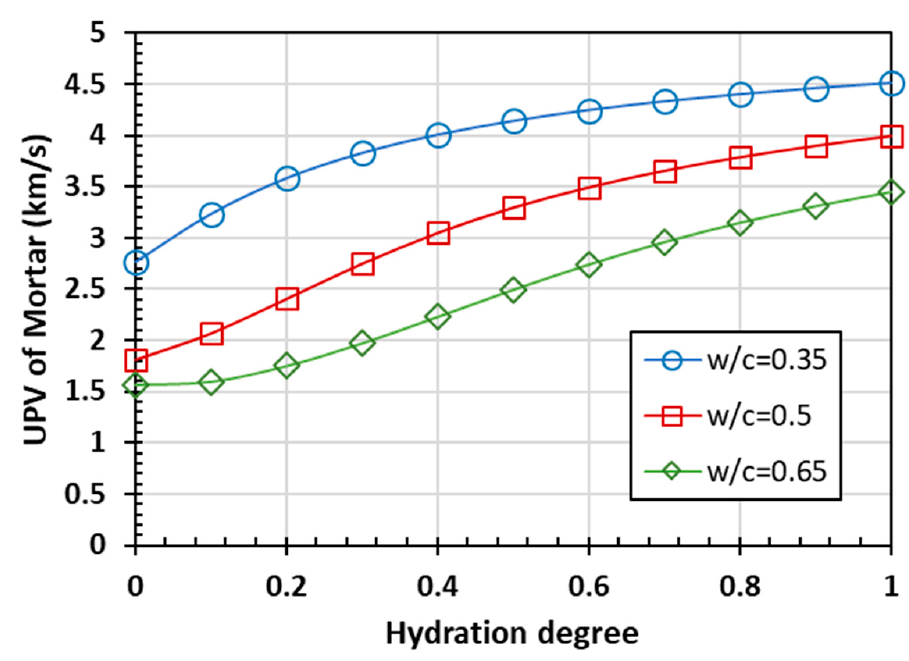
Figure 7. The ultrasonic pulse velocity prediction of mortar.